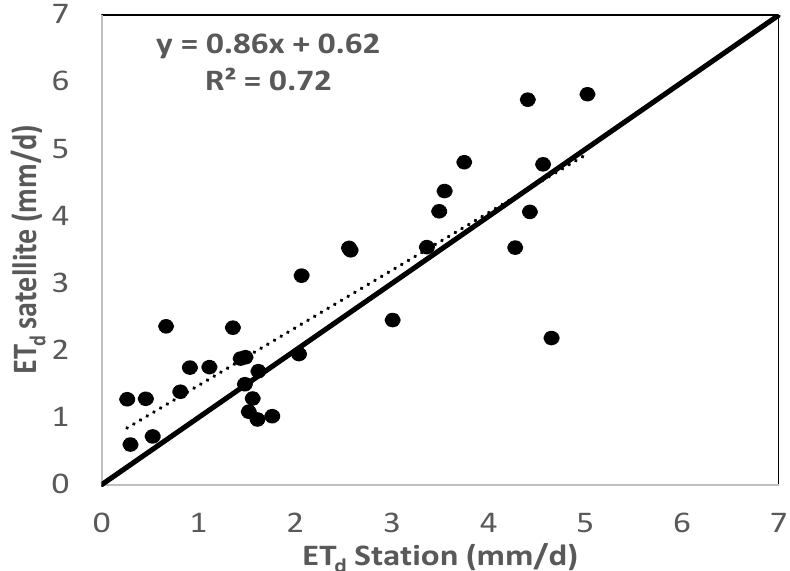
Figure 4. Comparison of daily evapotranspiration (ET d ) estimated from field data at both sites, with the ET d retrieved from data acquired by Landsat-8 OLI/TIRS, after applying the S-SEBI model.